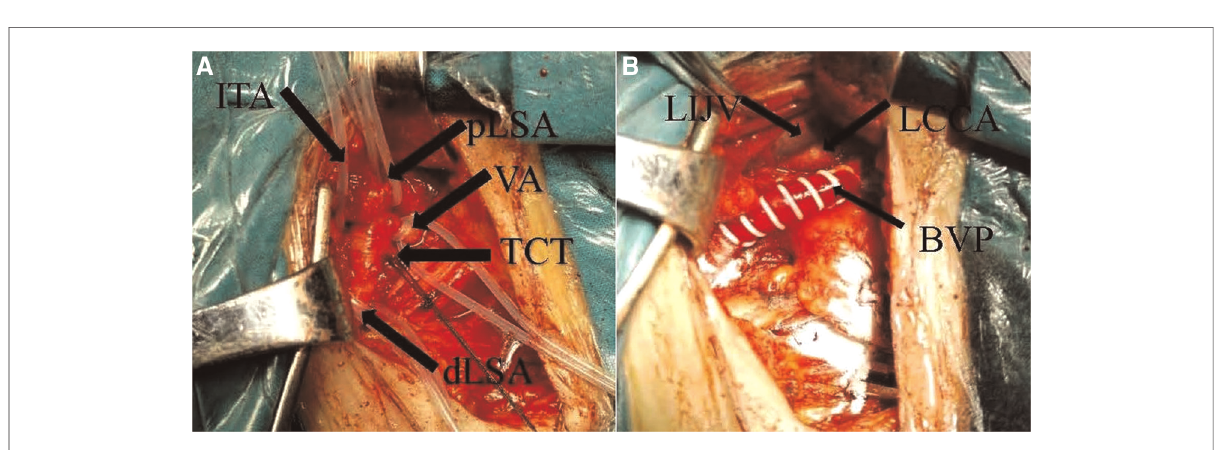
FIGURE 2 Intraoperative dissociation of the left subclavian artery and its branches, proximal narrowing of the lumen of the left subclavian artery is seen ( A ). Common carotid artery — left subclavian graft ( B ). PLSA, proximal left subclavian artery; DLSA, distal left subclavian artery; VA, vertebral artery; ITA, internal thoracic artery; TCT, thyroid trunk; BVP, arti fi cial vessel; LCCA, left common carotid artery; LIJV, left internal jugular